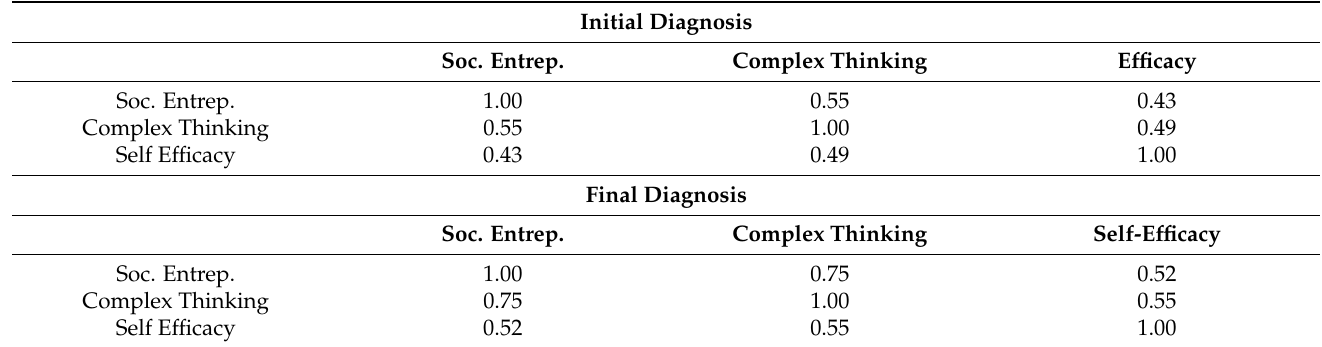
Table 8. Correlation of development of social entrepreneurship, complex thinking, and en- trepreneurial self-efficacy competencies (Initial–Final). Coefficient of determination.